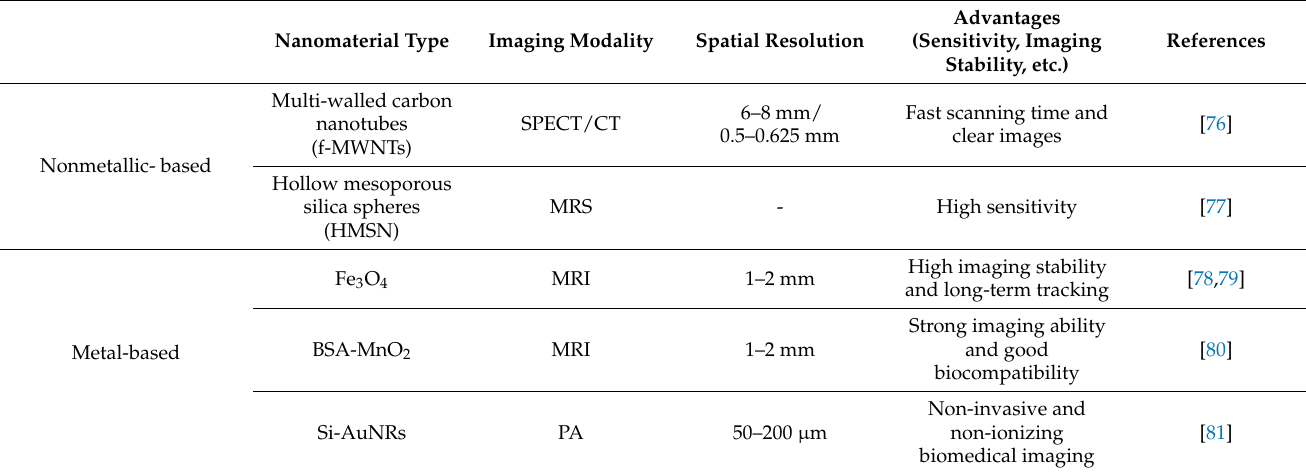
Table 1. The characteristics of various inorganic nanomaterials-based imaging modalities [75]. Nanomaterial Type Imaging Modality Spatial Resolution